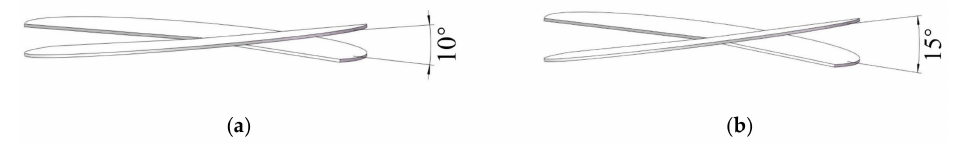
Figure 5. Static mixer-type susceptors with different cross angles: ( a ) 10 ◦ cross angle and ( b ) 15 ◦ cross angle.